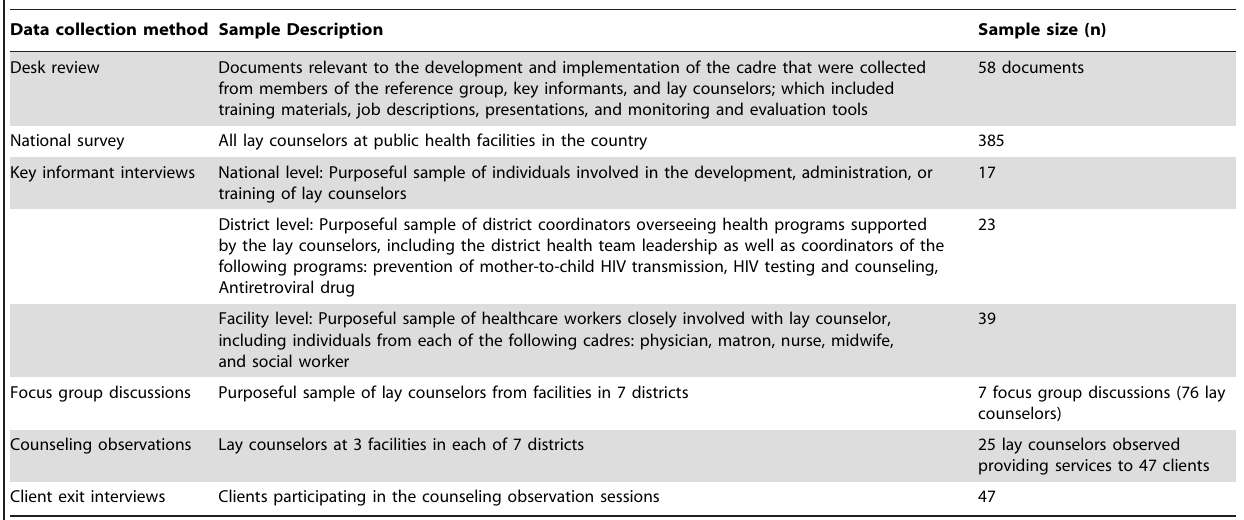
Table 1. Summary of data collection methods used in the evaluation of the lay counselor cadre in